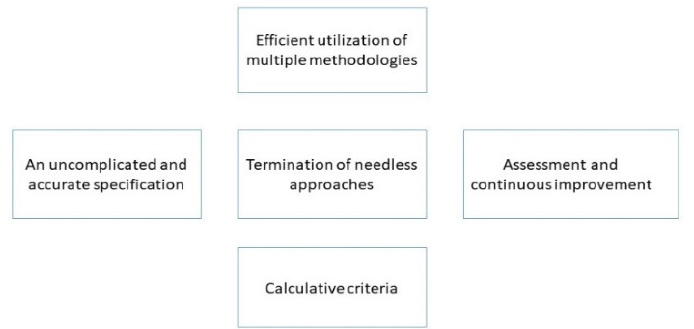
Figure 1. Recruitment and Selection Process.